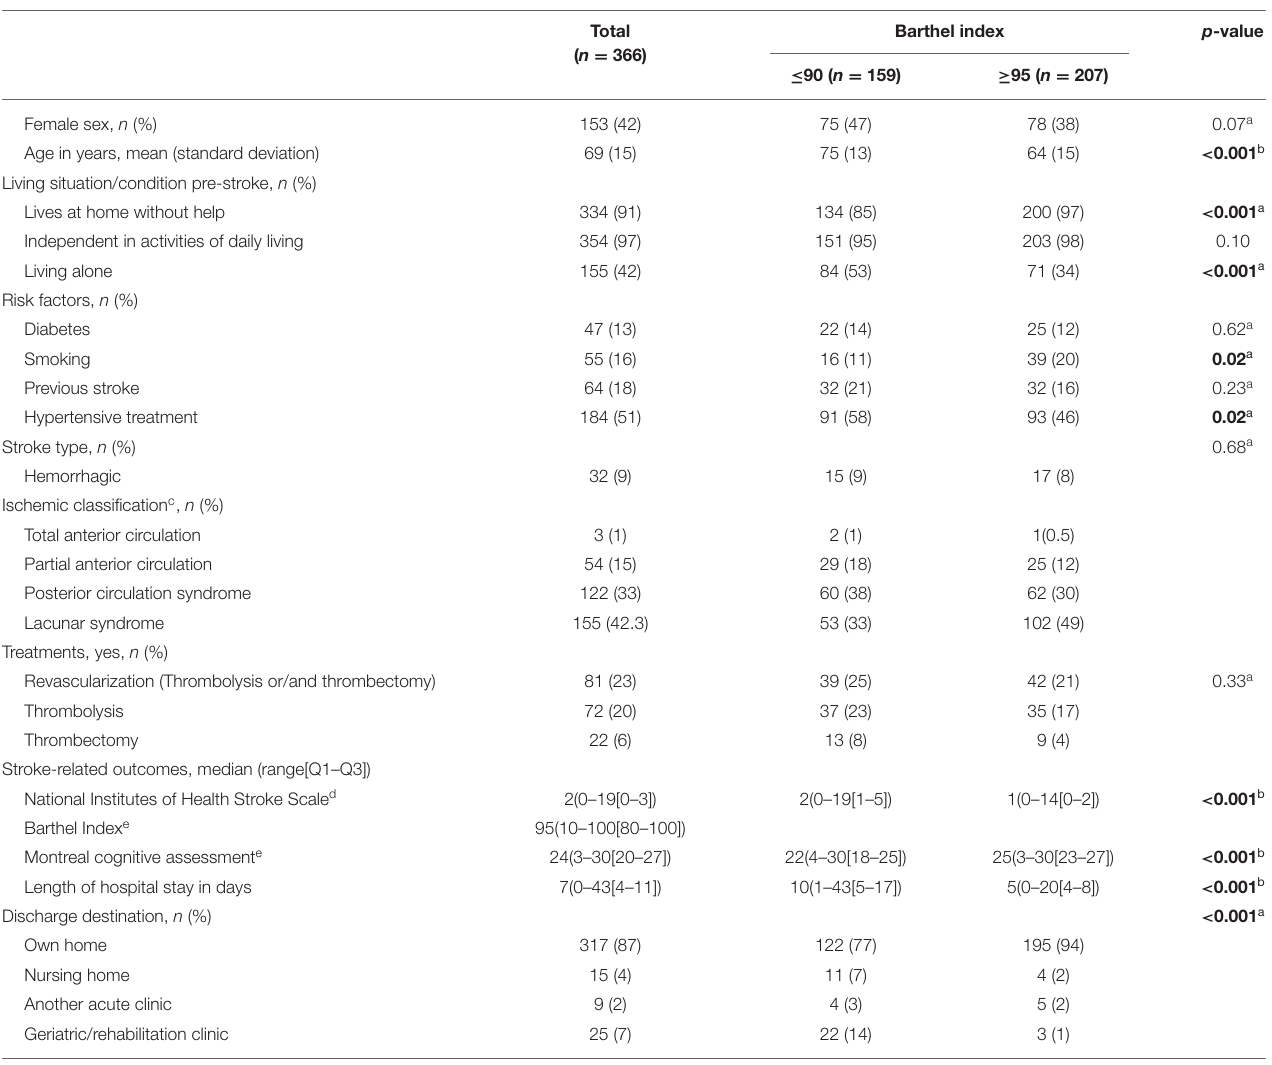
TABLE 1 | Baseline characteristics of the 366